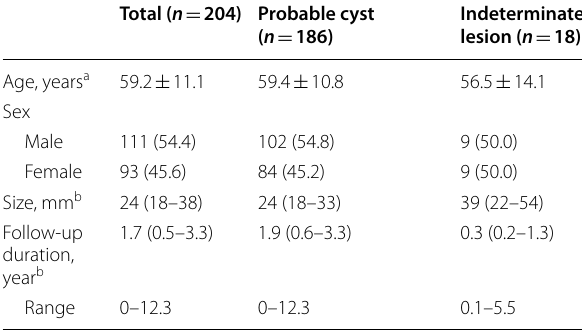
Unless indicated otherwise, data are percentages in parentheses a Data are means standard deviations, with ranges in parentheses ± b